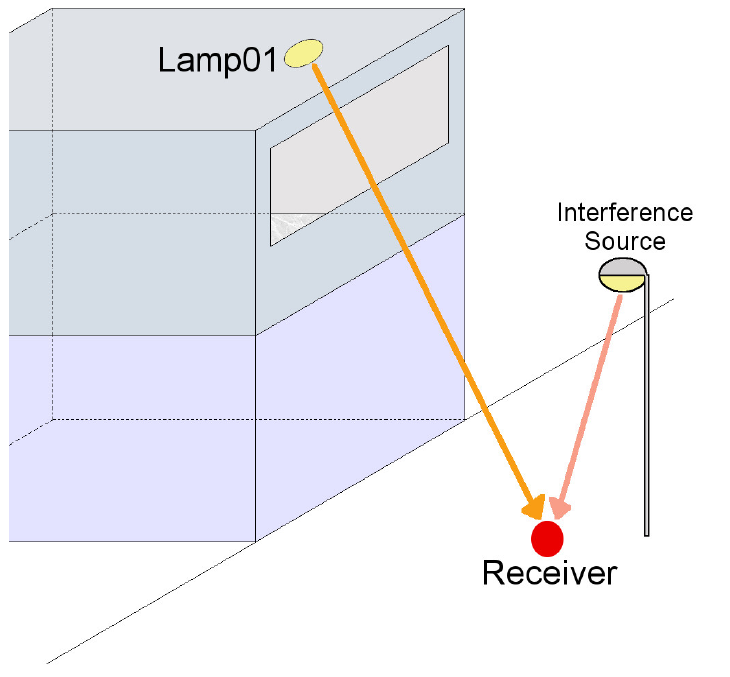
Figure 1. Eavesdropping scenario. The emitter is located on a second floor room and the eavesdropper is located outside. The existence of an interference source, a street lamp, is shown in the